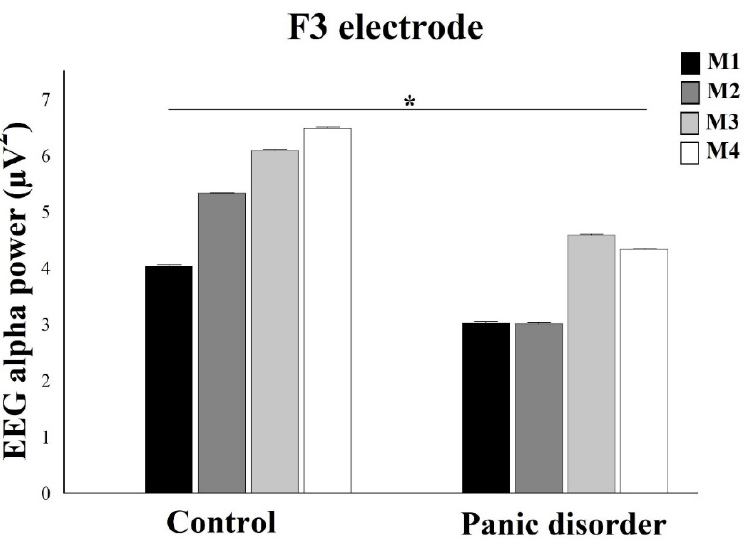
Figure 5. In relation to F3 electrode, the analysis shows differences between groups for all moments. The EEG alpha power decreases in the experimental group when compared to control. The inter- action between group and moment for the left dorsolateral prefrontal cortex is demonstrated by mean ± standard error, and statistically significant differences are indicated with *, p ≤